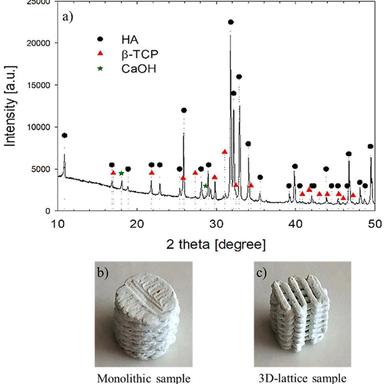
a) XRD pattern of the hydroxyapatite powder used for the robocasting of b) monolithic, and c) 3D-lattice samples.